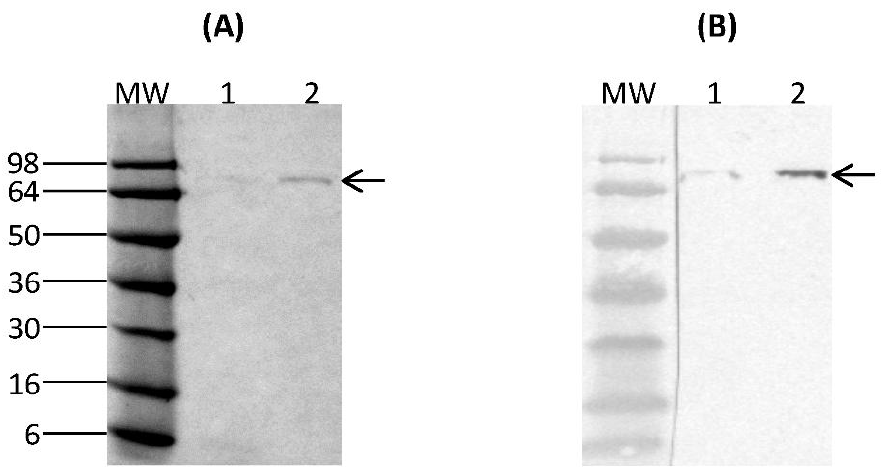
Figure 2. Immunoprecipitation analysis of purified rCSA fractions by ( A ) SDS-PAGE and ( B ) Western immunoblotting. Lane 1: unbound sample, Lane 2: elution containing rCSA. Arrows indicate the rCSA. MW: molecular weight marker SeeBlue ® Pre-Stained Protein Standard.